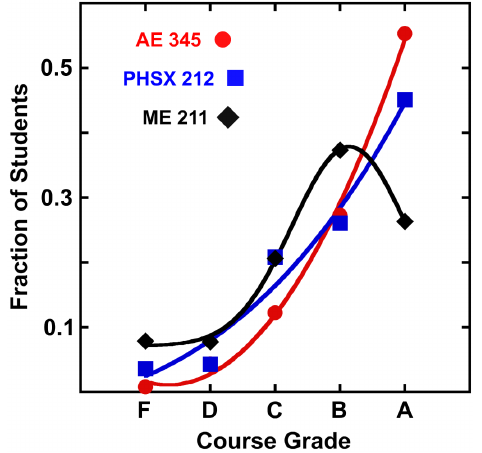
FIG. 10. The fraction of total enrollment in AE 345 (red circles), PHSX 212 (blue squares), and ME 211 (black diamonds) earning each letter grade from the fall semester of 2015 through the spring semester of 2018. The solid lines are generated from fits of these data to normal distributions and are meant to guide the